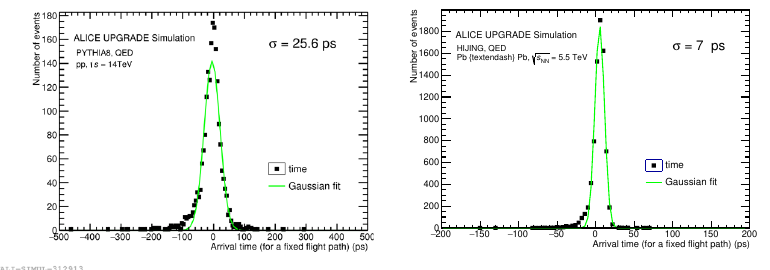
√ s = 14 TeV (left) and Pb–Pb